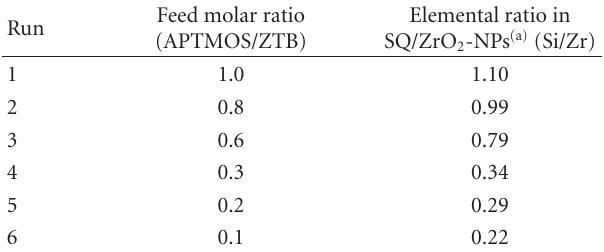
Table 1: Feed molar ratios of APTMOS/ZTB and elemental ratios of Si/Zr in SQ/ZrO 2 -NPs.